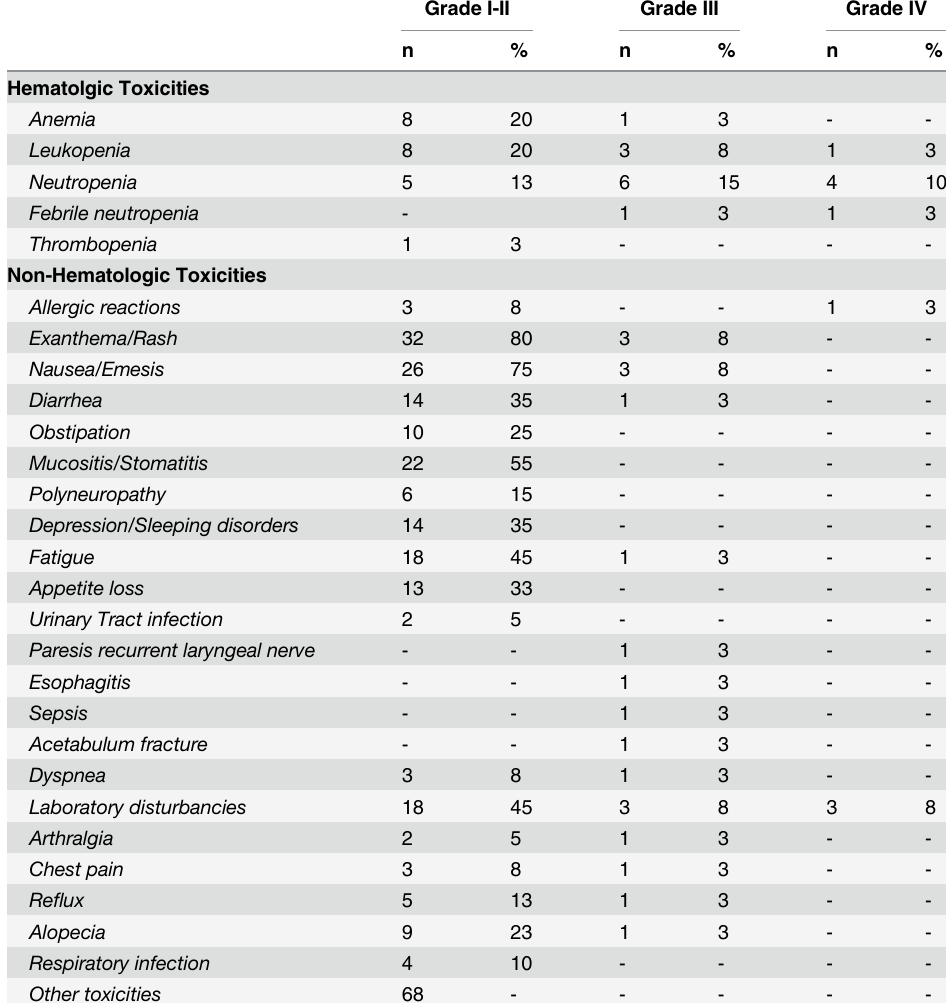
Table 2. Adverse Events (n =